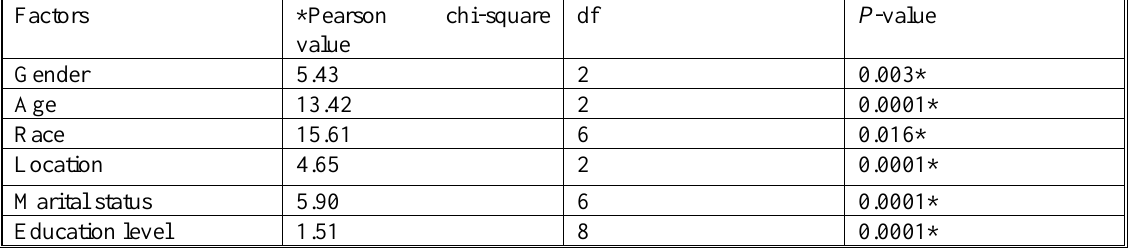
Table 3. Association between hypertension awareness and various factors